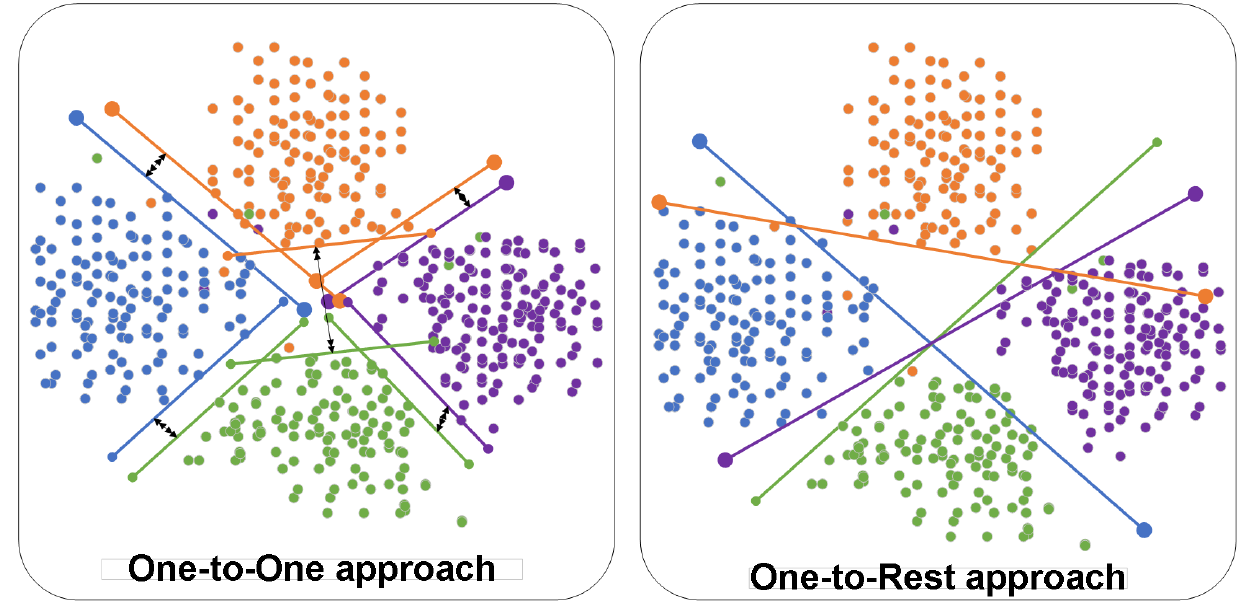
Figure 8. Multi-SVM